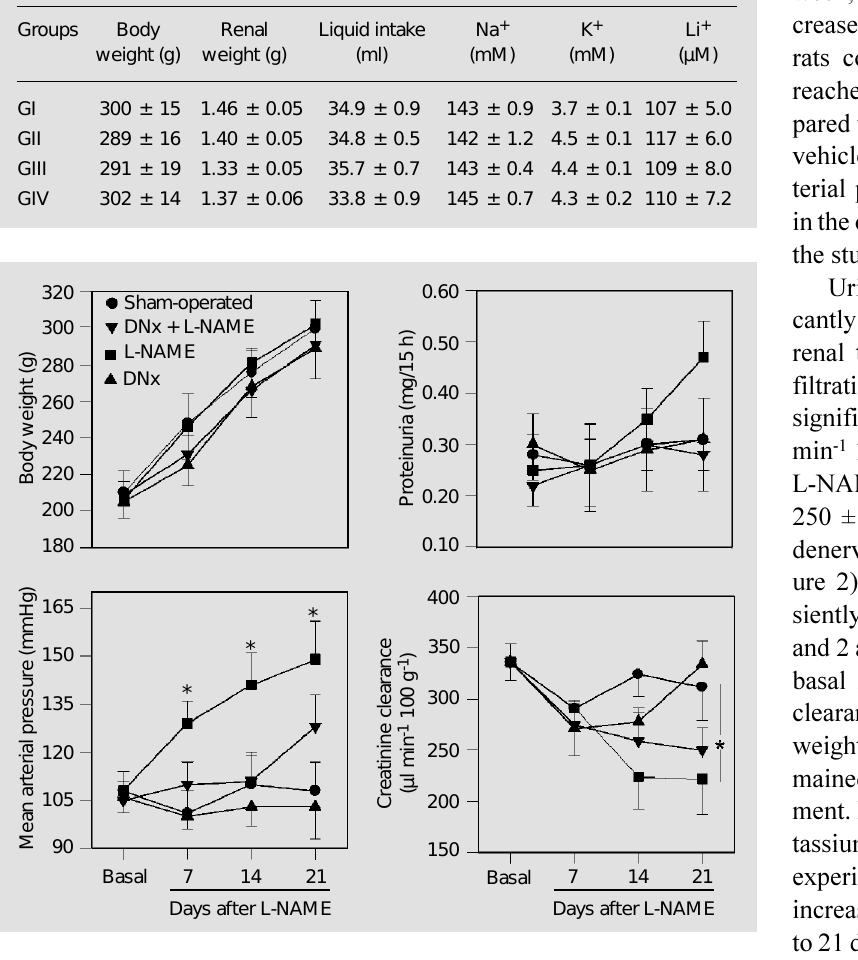
Figure 1 - Effect of oral L-NAME administration on body weight, proteinuria, mean arterial pressure and renal creatinine clearance in sham-operated rats compared to bilaterally renal denervated (DNx) rats. The data are reported as the mean ± SEM for 10 rats per group. *P<0.05 compared to the sham-operated vehicle-treated or sham-operated L-NAME-treated rats (ANOVA and Bonferroni’s contrast